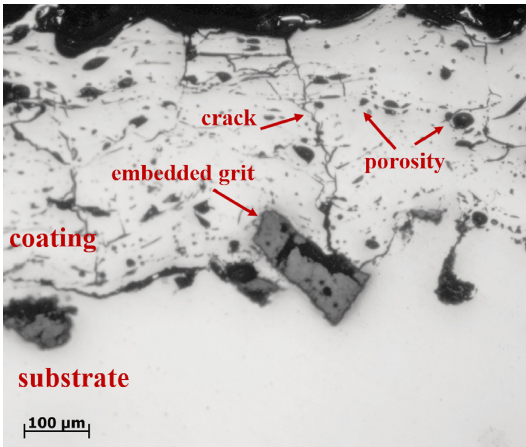
Figure 5. Coating cross-section on the substrate. OM, 100X. The presence of alumina used for surface preparation could be observed at the coating–substrate interface.